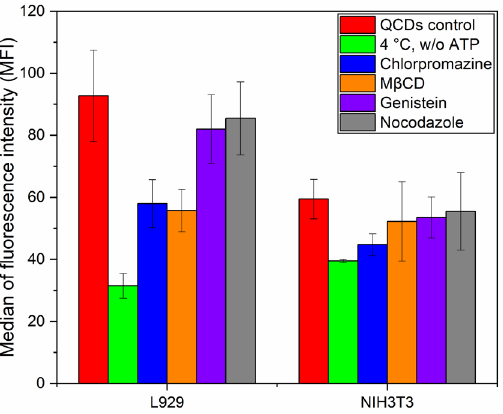
Figure 8. Inhibition of different endocytic mechanisms in L929 and NIH/3T3 cells immediately after adding the QCDs concentration of 200 µg/mL; incubation time of inhibitors was 2 h.